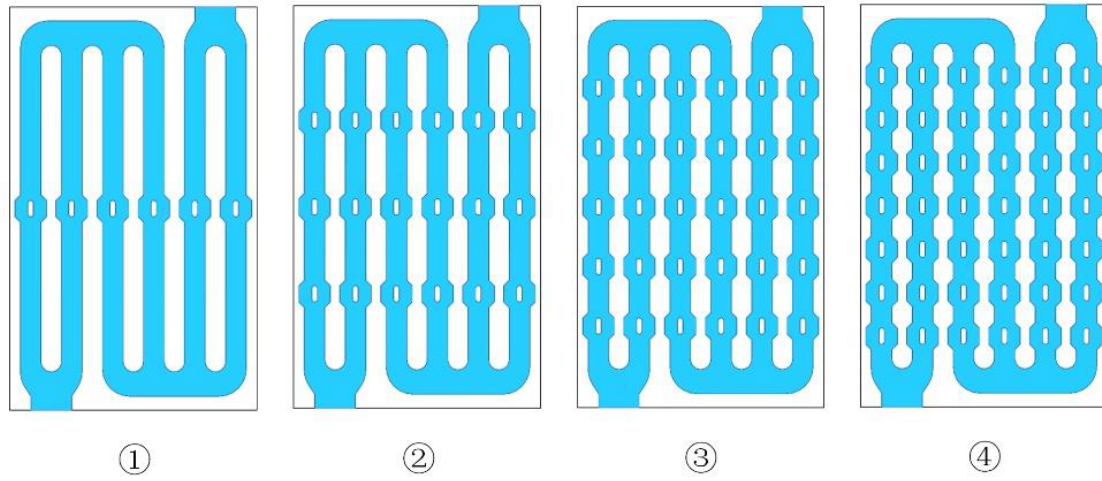
Figure 6. Different numbers of disturbance structures.